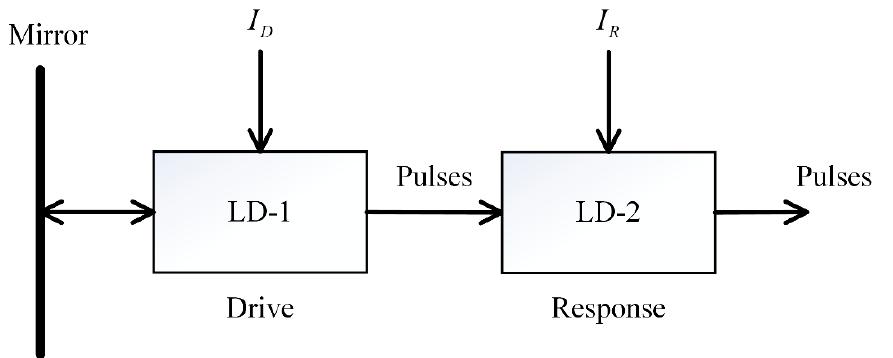
Figure 1. Schematic illustration of two cascaded photonic neurals.